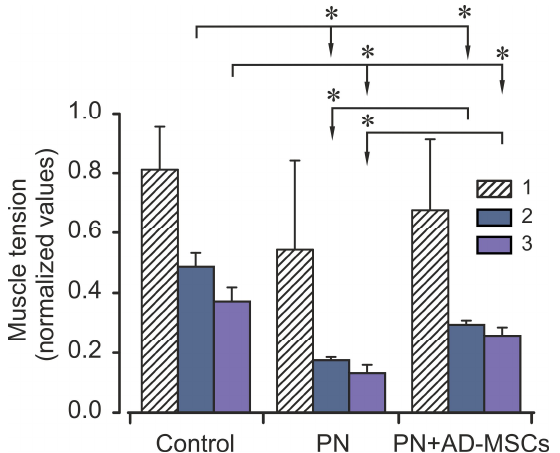
Figure 2. Averaged characteristics (mean ± SD) of normalized values of the triceps surae muscle strength during different phases of the electrical stimulation of Control animals, mice with peripheral neuropathy (PN) and treated animals with peripheral neuropathy (PN+AD-MSCs). Asterisks (*) designated significant differences ( p < 0.05) in the muscle strength during the same stimulation phases between animals of all groups. 1, 2 and 3 –phases of the electrical stimulations (0–100 s, 101–200 s and 201–900 s,